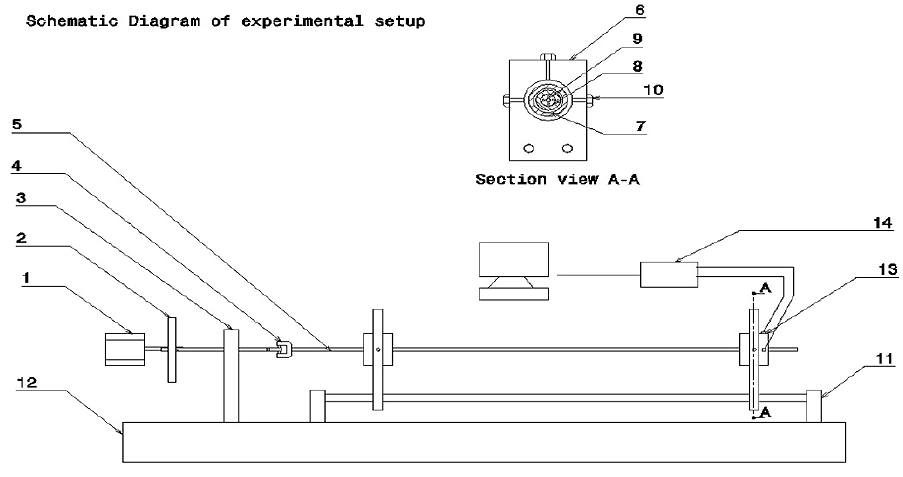
Fig. 2. Schematic diagram of the test rig.